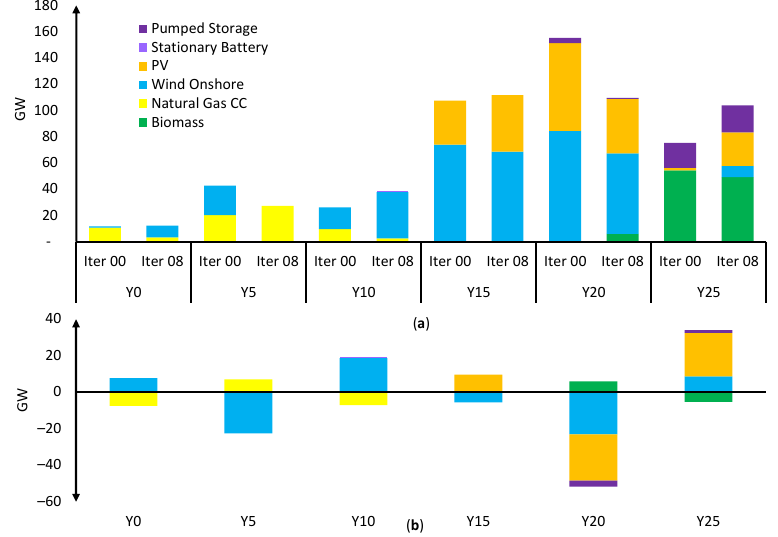
Figure 11. Change of endogenous investment over iterations (perfect foresight): ( a ) technology mix for iteration 0 and iteration 8; ( b ) delta between iteration 0 and iteration 8 per year and technology.